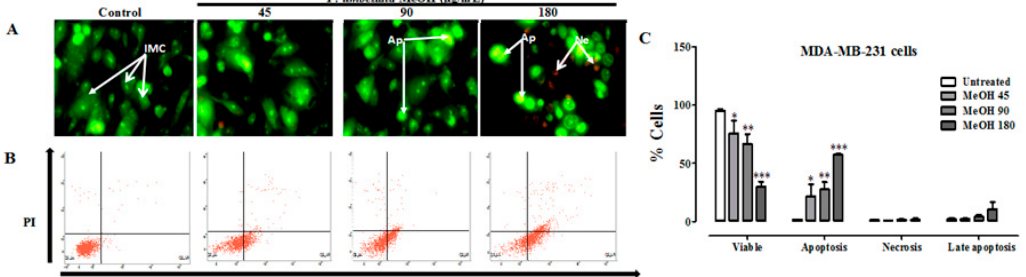
Figure 2. Effect of F. umbellata extracts on cancer cell death. Representative fluorescence microscopic images (400×) of cells double-stained with acridine orange (0.3 mg/mL) and ethidium bromide (1 mg/mL) ( A ); and dot plot representative of one experiment of apoptosis measurement by